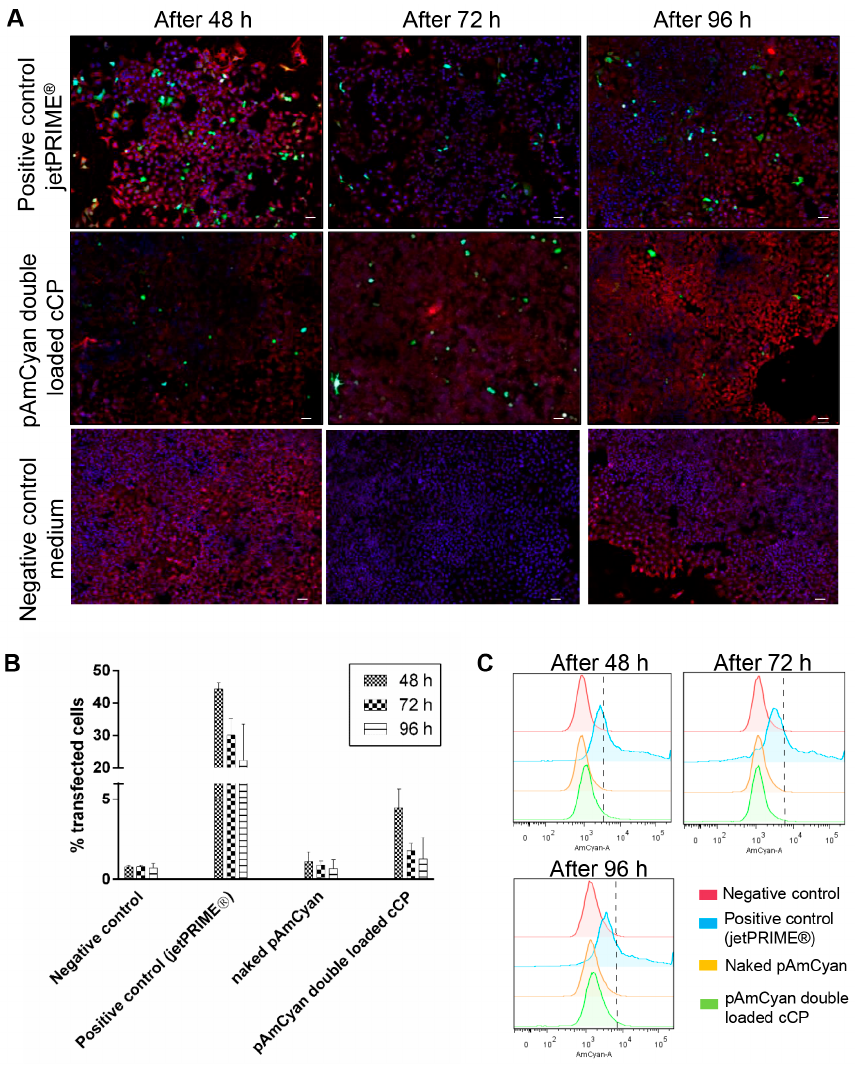
Figure 7. ( A ) Representative confocal images of A549 cells transfected with pAmCyan double loaded pAmCyan by using jetPRIME ® as positive control and only cell culture medium as negative control. Transfection was analyzed with CLSM after 48 h, 72 h, and 96 h. Green fluorescence reveals cells successfully transfected with the polyplexes while their morphology remains consistent with non- transfected cells (red: cell membrane; blue: cell nucleus; scale bar 50 µm). ( B ) The transfection efficiency was further quantified using flow cytometry, which indicated the highest amount of transfection after 48 h for pAmCyan double loaded cCP. ( C )Representative graphs obtained with flow cytometer.